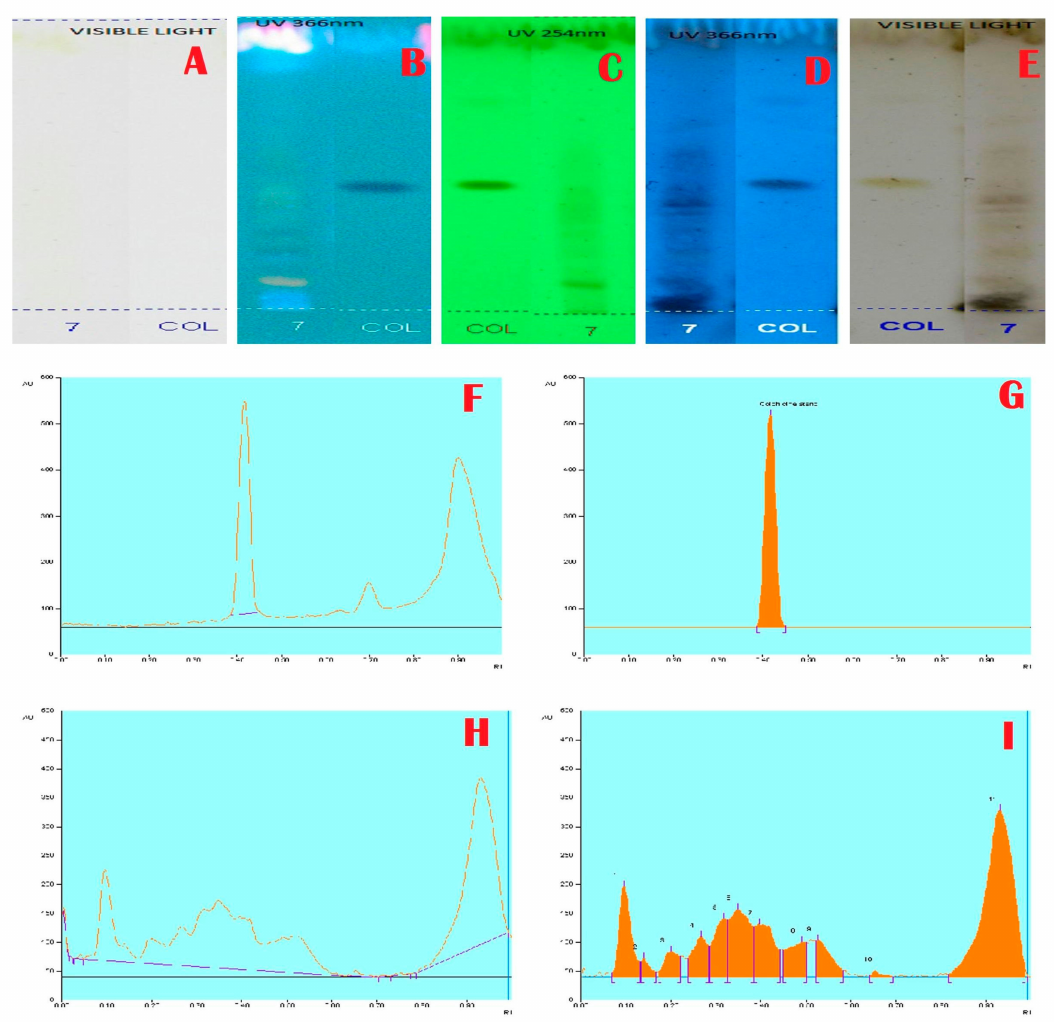
Figure 3. Alkaloids Profile and Chromatogram of A. aethiopicum. ( A ): HPTLC profile of A. aethiopicum under visible light; ( B ): HPTLC profile of A. aethiopicum under UV light at 366 nm before derivatization; ( C ): HPTLC profile of A. aethiopicum under UV light at 234 nm before derivatization; ( D ): HPTLC profile of A. aethiopicum under visible light after derivatization; ( E ): HPTLC profile of A. aethiopicum under UV light at 366 nm after derivatization; ( F ): HPTLC chromatogram of ethanolic extracts of A. aethiopicum —base line display scanned at 254 nm; ( G ): HPTLC chromatogram of ethanolic extracts of A. aethiopicum —peak densitogram display scanned at 254 nm; ( H ): HPTLC profile of standard Colchichine—peak baseline display scanned at 254 nm; ( I ): HPTLC chromatogram of standard Colchichine—peak densitogram display scanned at 254